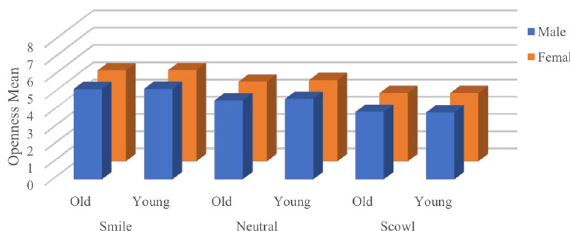
Fig. 13 Facial expression and Openness. This graph presents interaction of facial expression, age, and gender on mean ratings of